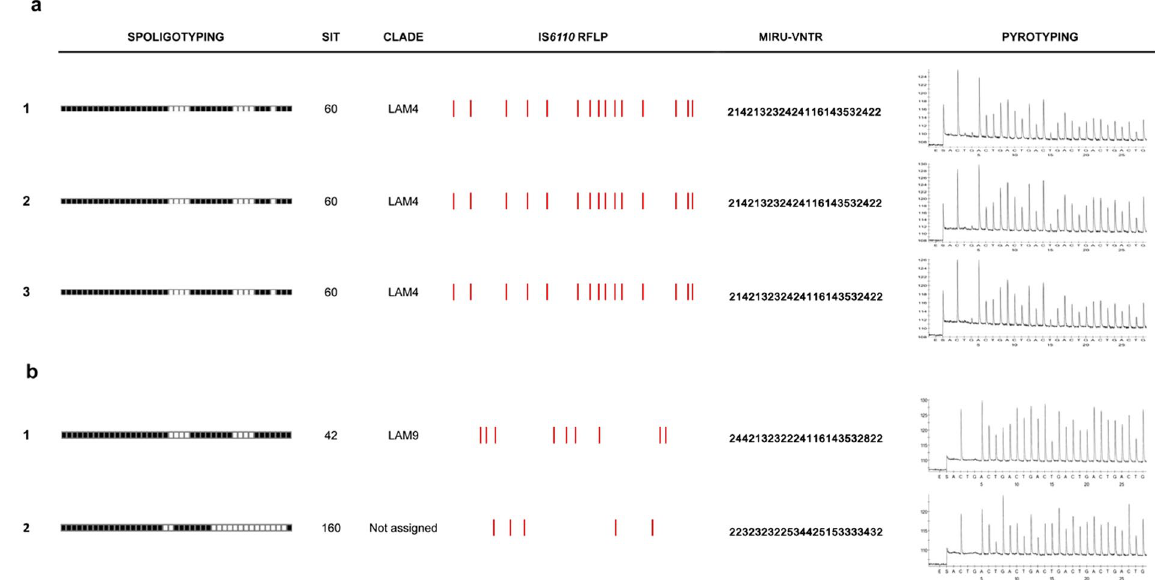
Figure 2. Examples of spoligotyping, IS 6110 -RFLP, 24-loci MIRU-VNTR, and PyroTyping results for some of the M. tuberculosis isolates included in this study. ( a ) Results for isolates sharing the same spoligotyping, IS 6110 -RFLP, 24-loci MIRU-VNTR, and PyroTyping profiles. ( b ) Results for isolates showing different spoligotyping, IS 6110 -RFLP, 24-loci MIRU-VNTR, and PyroTyping profiles. RFLP: restriction fragment length polymorphism. MIRU-VNTR: mycobacterial interspersed repetitive units - variable number of tandem repeats.